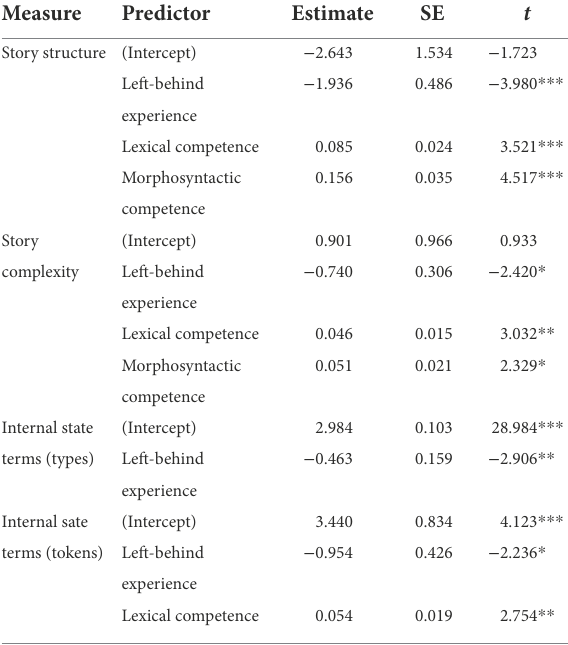
TABLE 4 Significant terms in the final model for performance in each outcome measure of macrostructure competence in the follow up